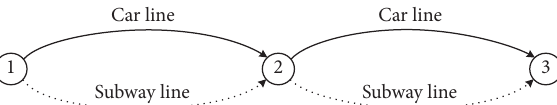
Figure 1: Test road